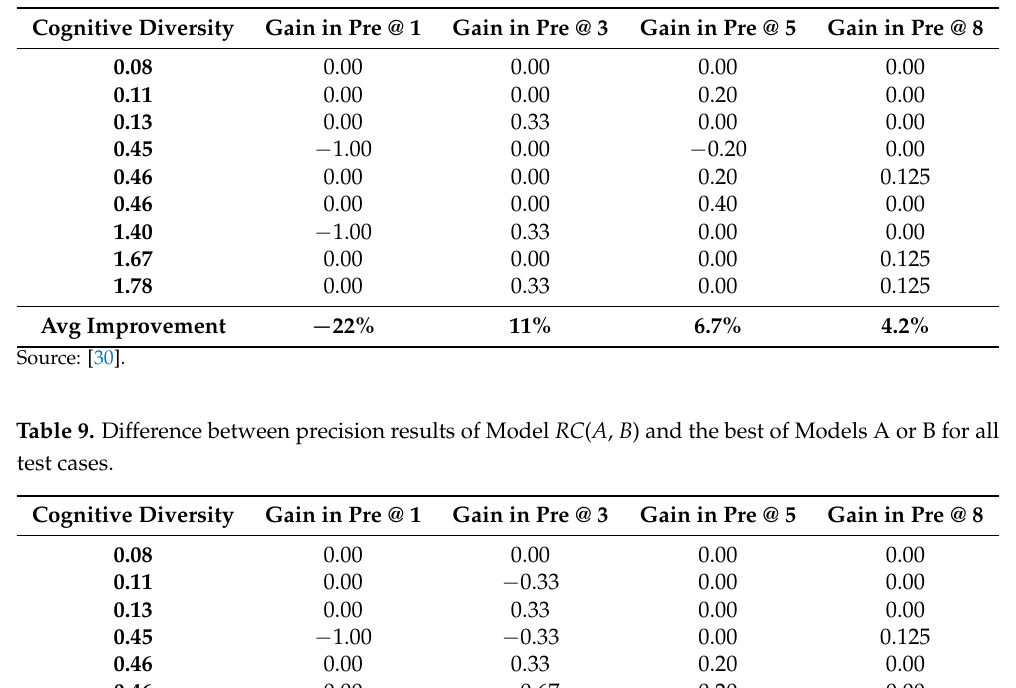
Table 8. Difference between precision results of Model SC ( A , B ) and the best of Models A or B for all test cases.